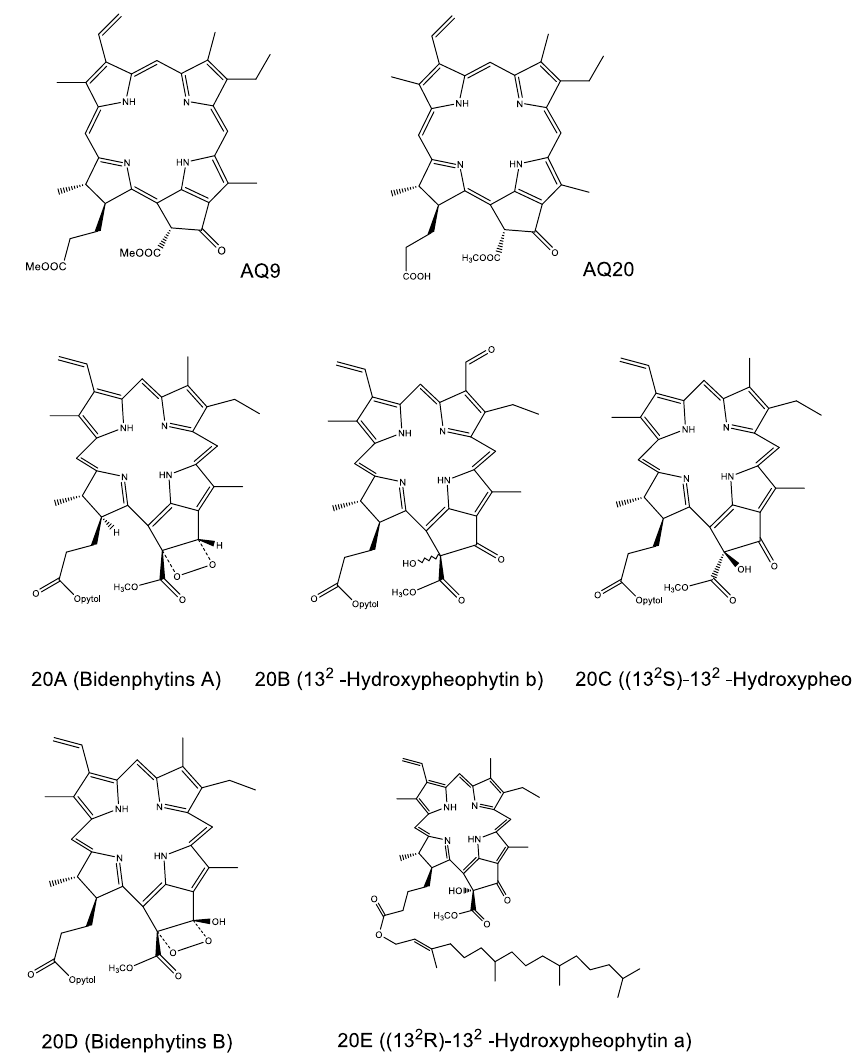
Figure 6. Structures of PA and its analogues. PA (AQ20), PA analogues (AQ9, 20A – E).